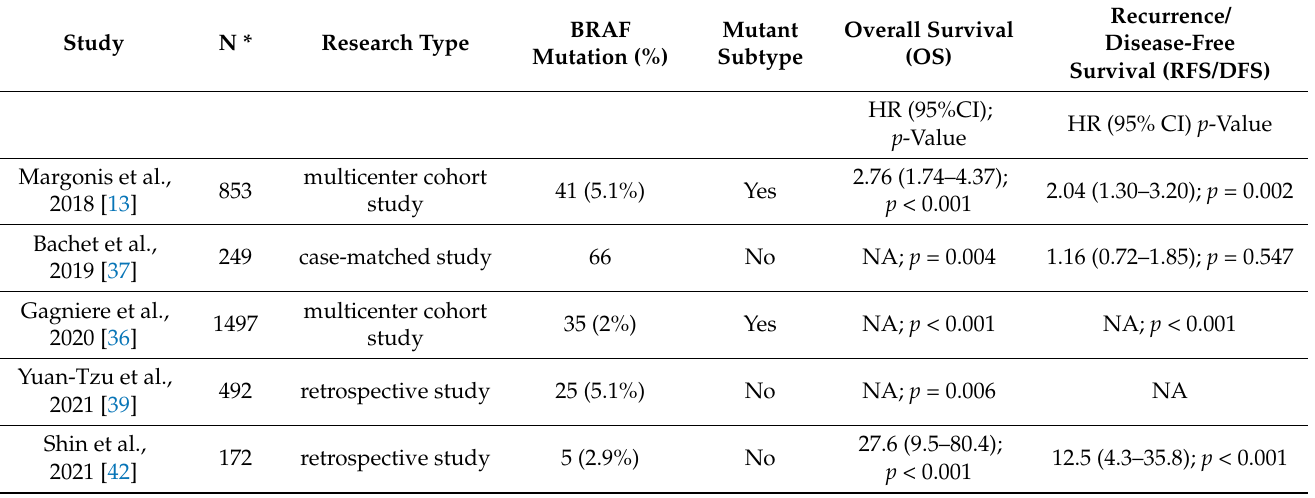
Table 1. Summary of recent studies reporting survival outcomes of patients with BRAF